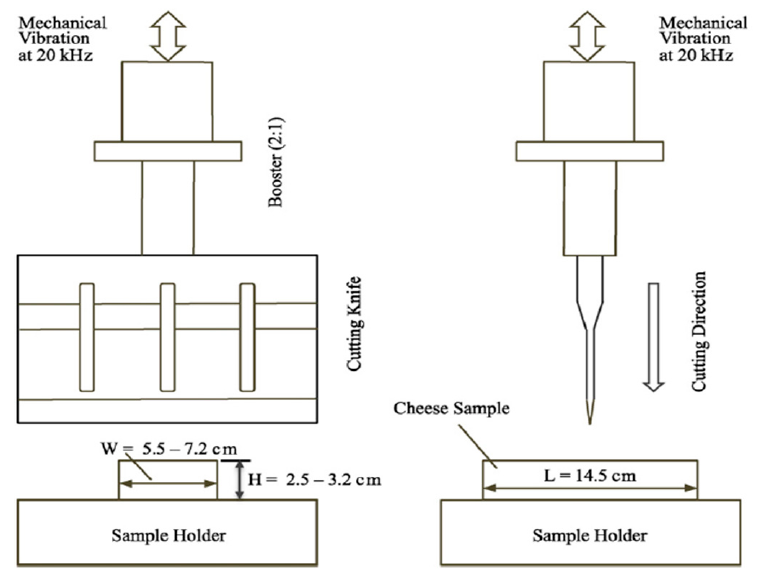
Figure 2. Ultrasonic cutting system with cutting knife (reprinted with permission from Ref. [43] Copyright 2016 Elsevier).